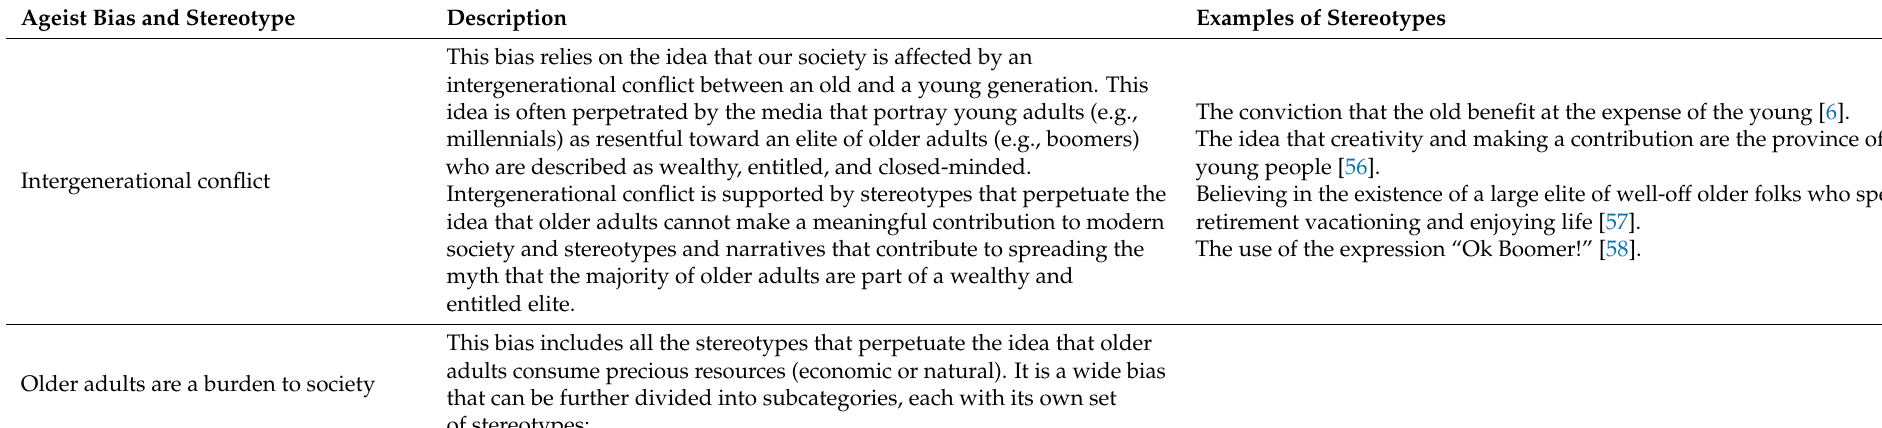
Table 1. Ageist biases and stereotypes were used for the analysis of the Age Workshop stories. Ageist Bias and Stereotype Description